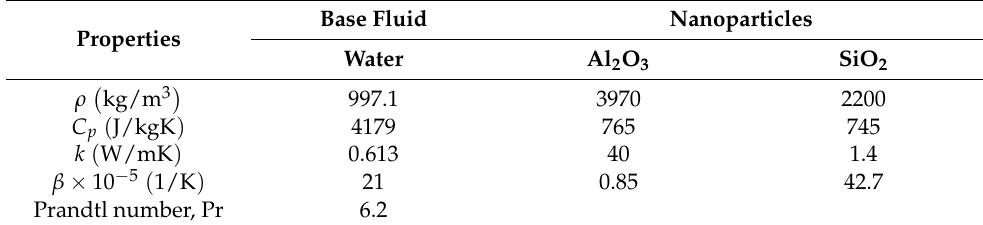
Table 1. Thermophysical properties of nanoparticles and water. Properties